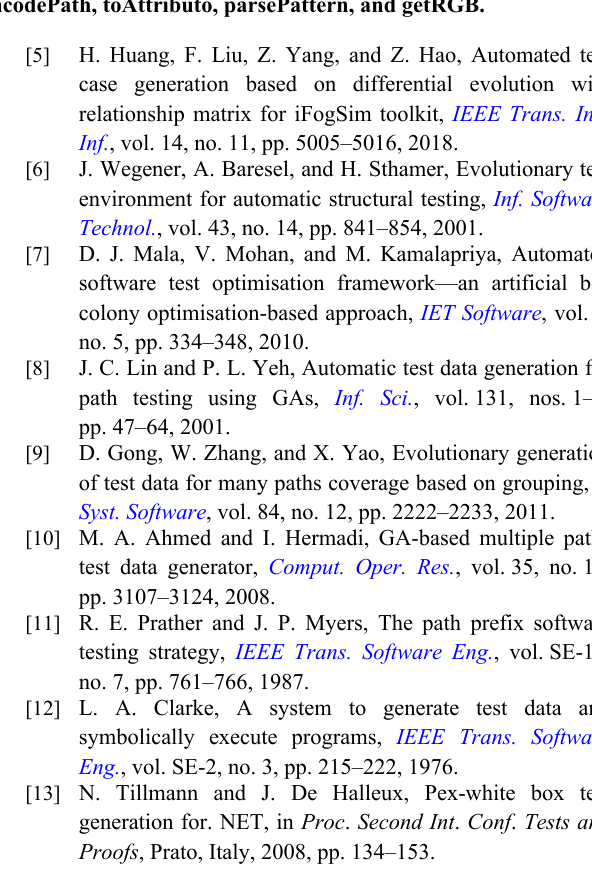
Fig. 9 Box plots for metricMatch, parseString, encodePath, toAttributo, parsePattern, and